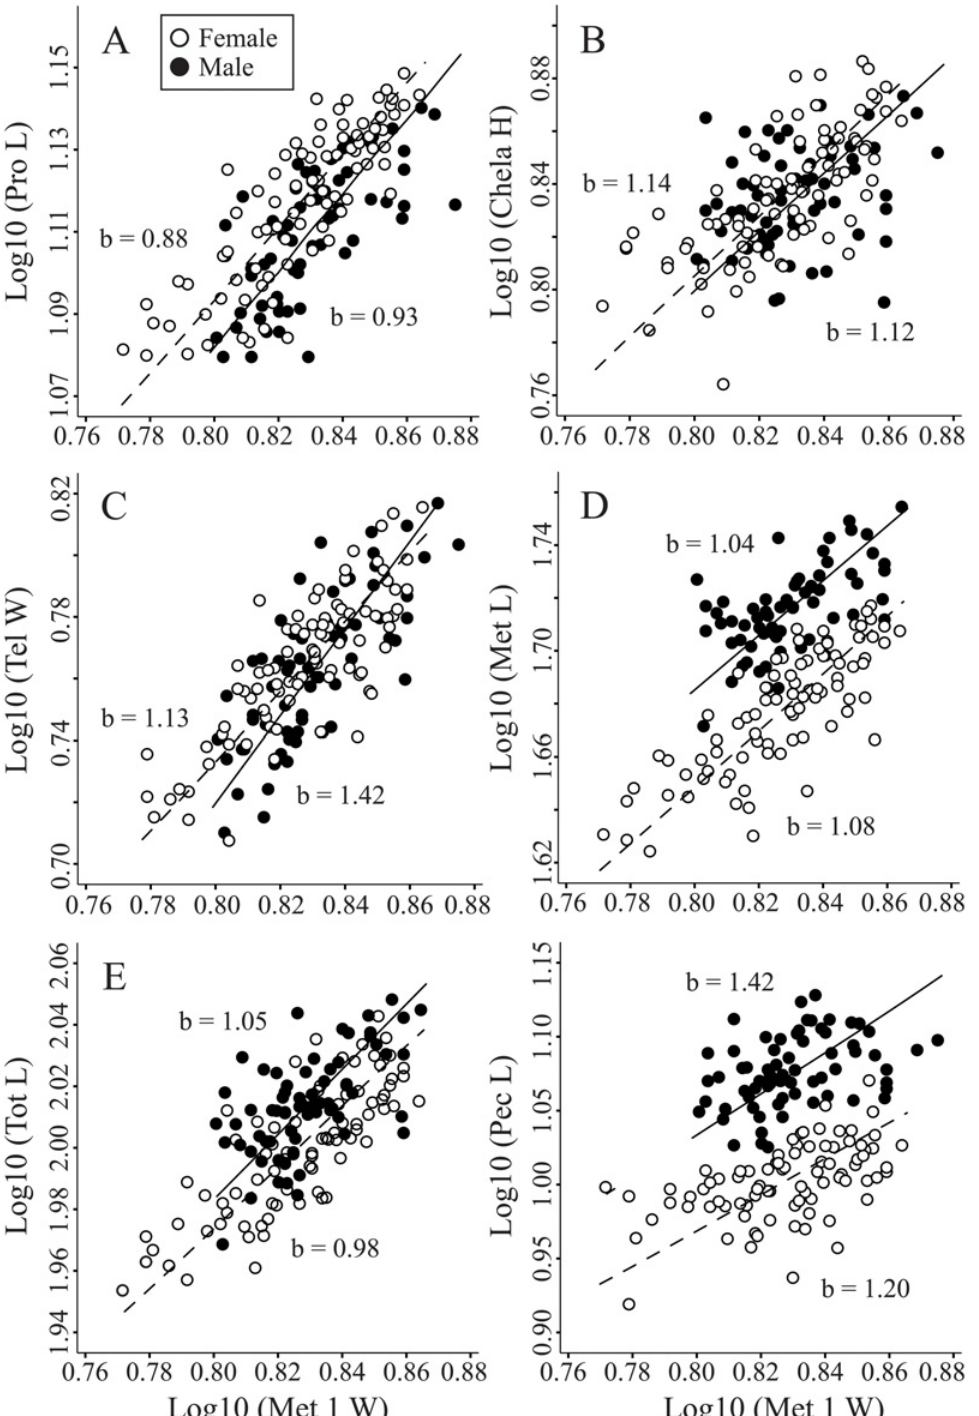
Fig 4. Select allometric relationships of female (open circles, dashed line) and male (closed circles, solid line) Hadrurus arizonensis . A – F depict static allometric scaling relationships of select body characters with metasoma segment 1 width (Met 1 W) as the reference character. A. Prosoma length (Pro L) plot illustrates a difference in y-intercept between the sexes. B. Chela height (Chela H) illustrates no difference between the sexes. C. Telson width (Tel W) illustrates a difference in slopes between the sexes. D – F Illustrate differences in both y-intercept and in shifts along the slope for metasoma length (Met L), total length (Tot L), and pectine length (Pec L). Scales are logarithmic. N = 84 – 90 females and 65 – 83 males. Additional details are supplied in S3